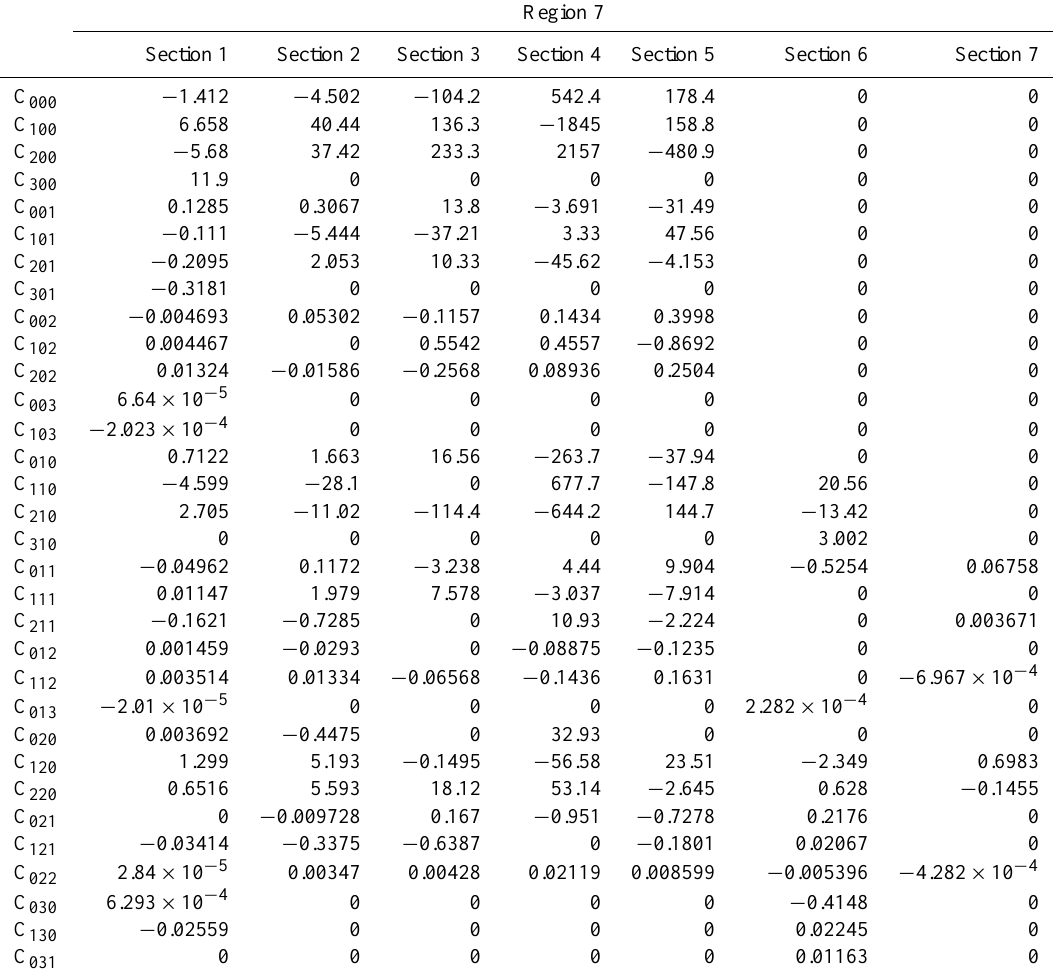
Table 9. Similar to Table 3, but for region